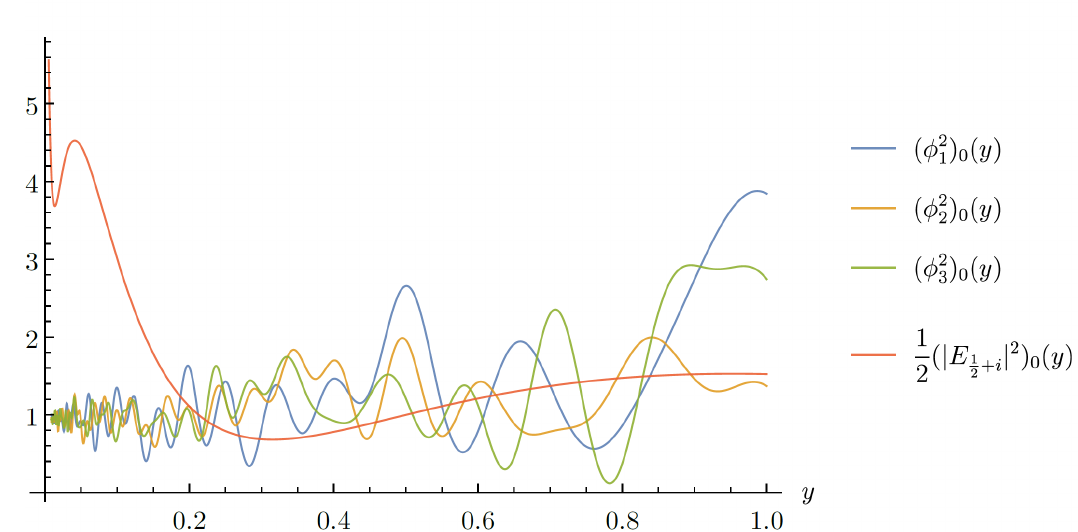
τ ) (rescaled by a + i ( 2 R 1 dx φ i ( τ ) 2 , for 2 ) 0 ( y ) := i − 1 2